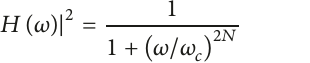
Choosing the wrong cut-off frequency can result in huge alterations in the signal and irrelevant or, worse, erroneous data decisions. Equation (2) describes the operation of low pass filtering.